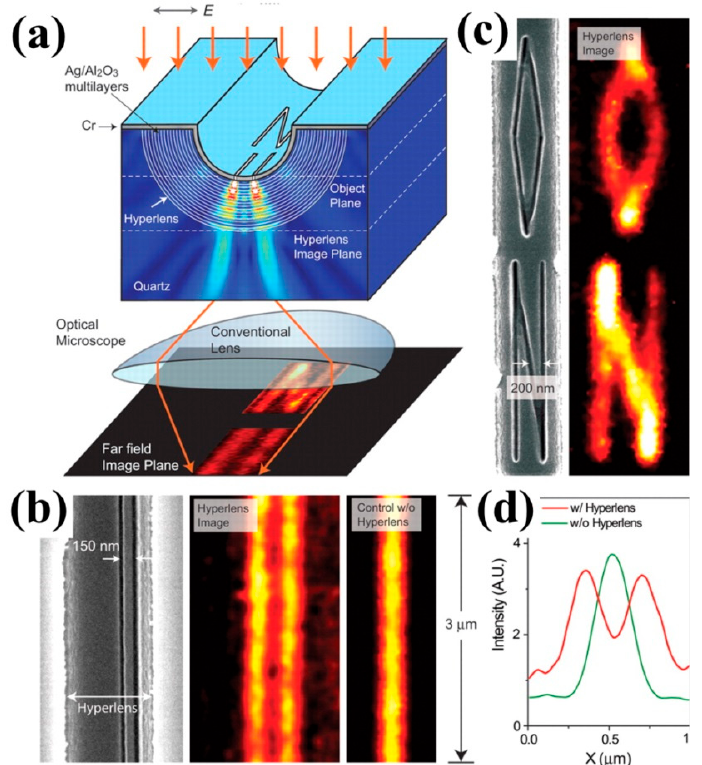
Figure 3. ( a ) Schematic of the multilayer hyperlens and its working mechanism. ( b ) SEM image of the slits and far-field images with and without hyperlens. ( c ) SEM image of letters “O” and “N” and far-field image with hyperlens. ( d ) Averaged cross-section of both hyperlens image and the control case without the hyperlens. Reproduced with permission from [89]. Copyright the American Association for the Advancement of Science, 2007.